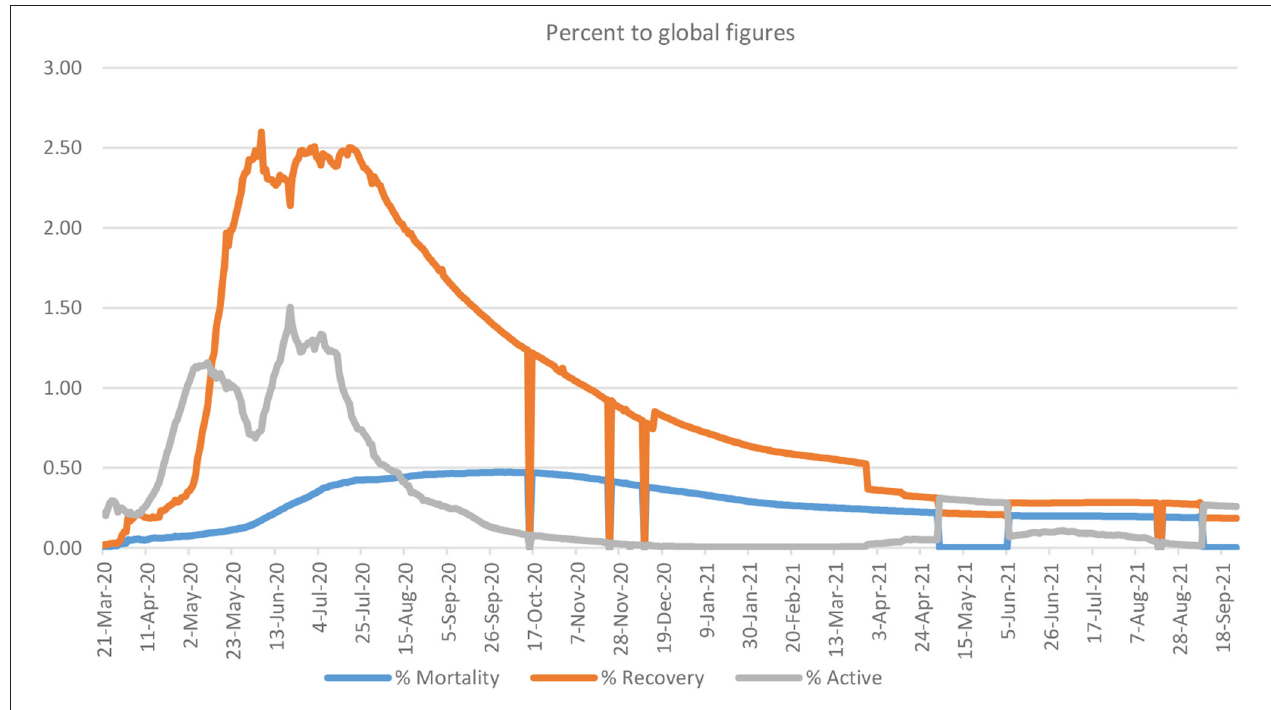
FIGURE 2 | Global comparisons of COVID-19